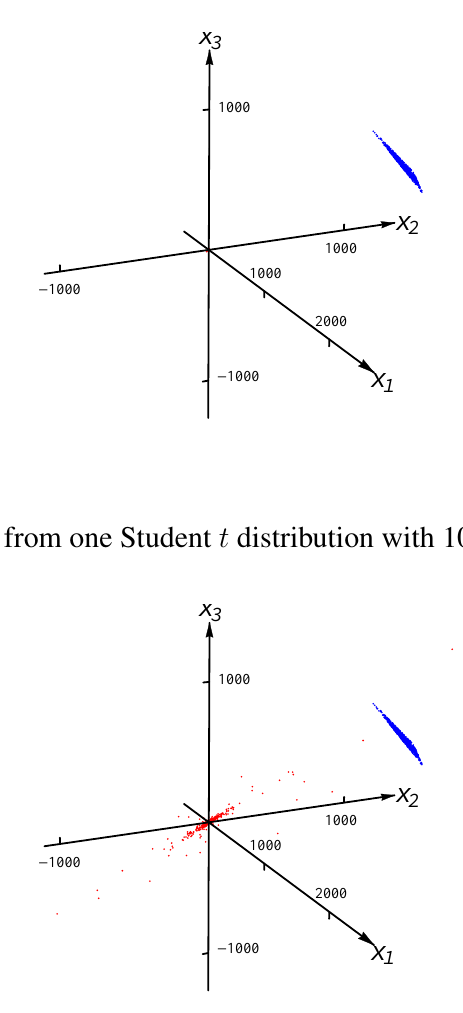
Figure 5. Sample from one Gaussian distribution with 10% artificial outliers.